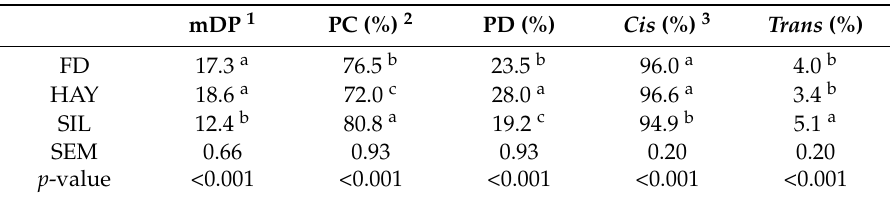
<0.001 <0.001 <0.001